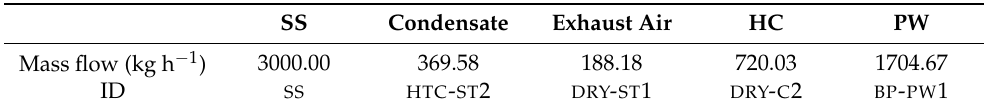
Table 6. Mass balance under optimal conditions (mechanical dewatering to 70% TS , flash pressure 1.6 bar(a)), resulting in a hydrochar with 90% total solids